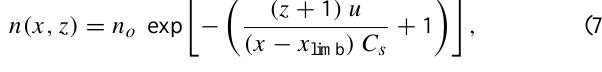
For comparison with magnetometer data: (cid:2) B